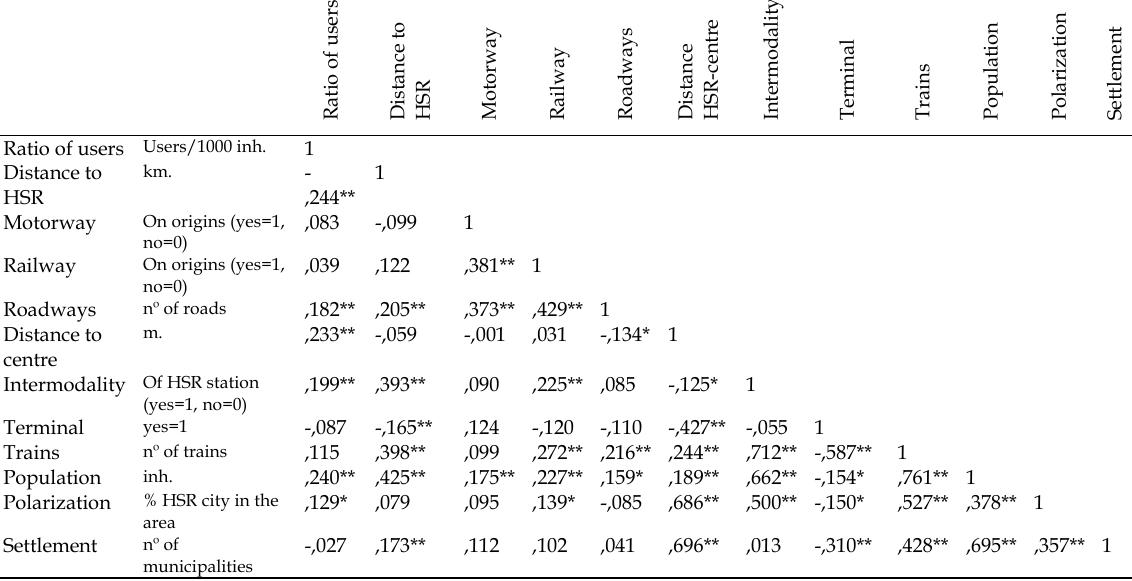
e r u s o f o i a t R